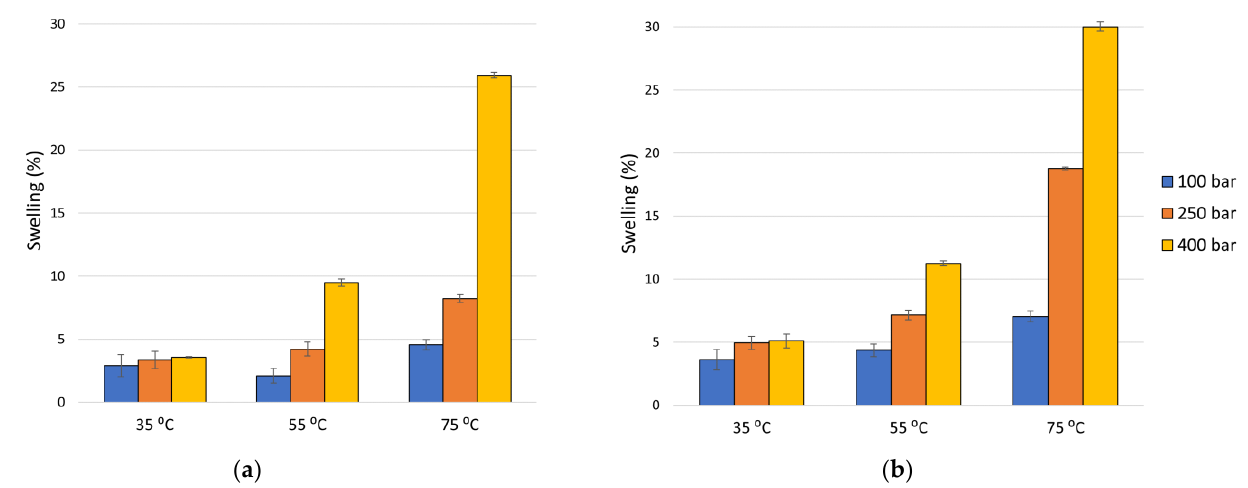
Figure 2. Swelling of PLA filaments, ( a ) under CO 2 in supercritical conditions, and ( b ) under scCO 2 -assisted impregnation with ketoprofen.